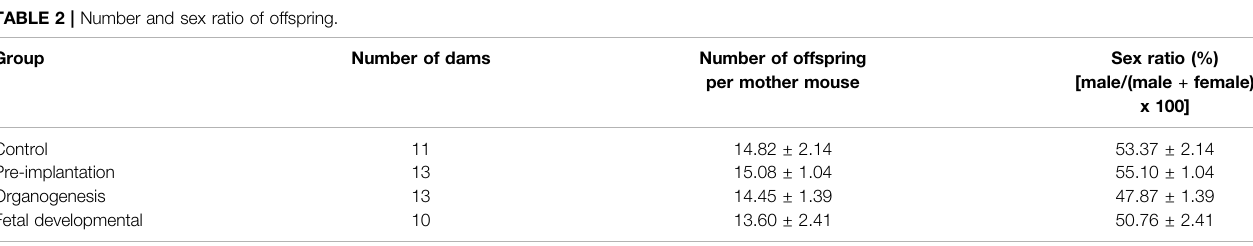
TABLE 2 | Number and sex ratio of offspring.